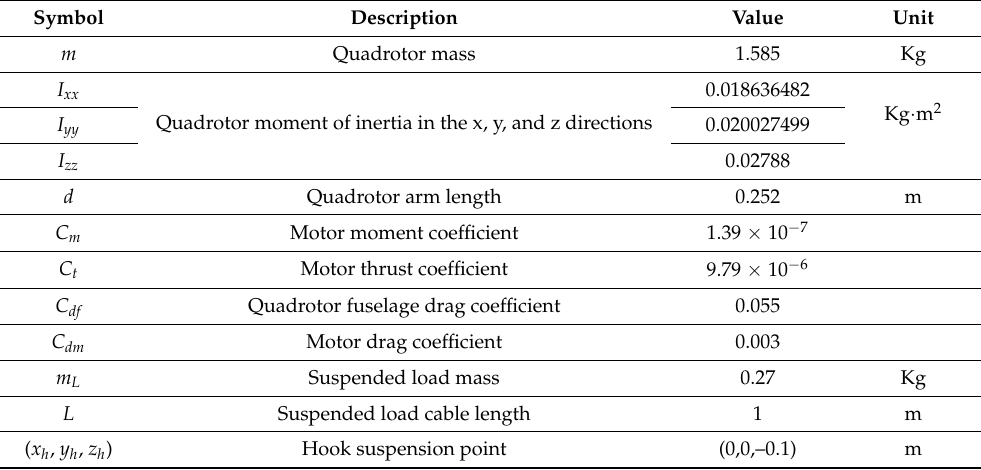
Table 1. Parameters of the quadcopter and the suspended load.